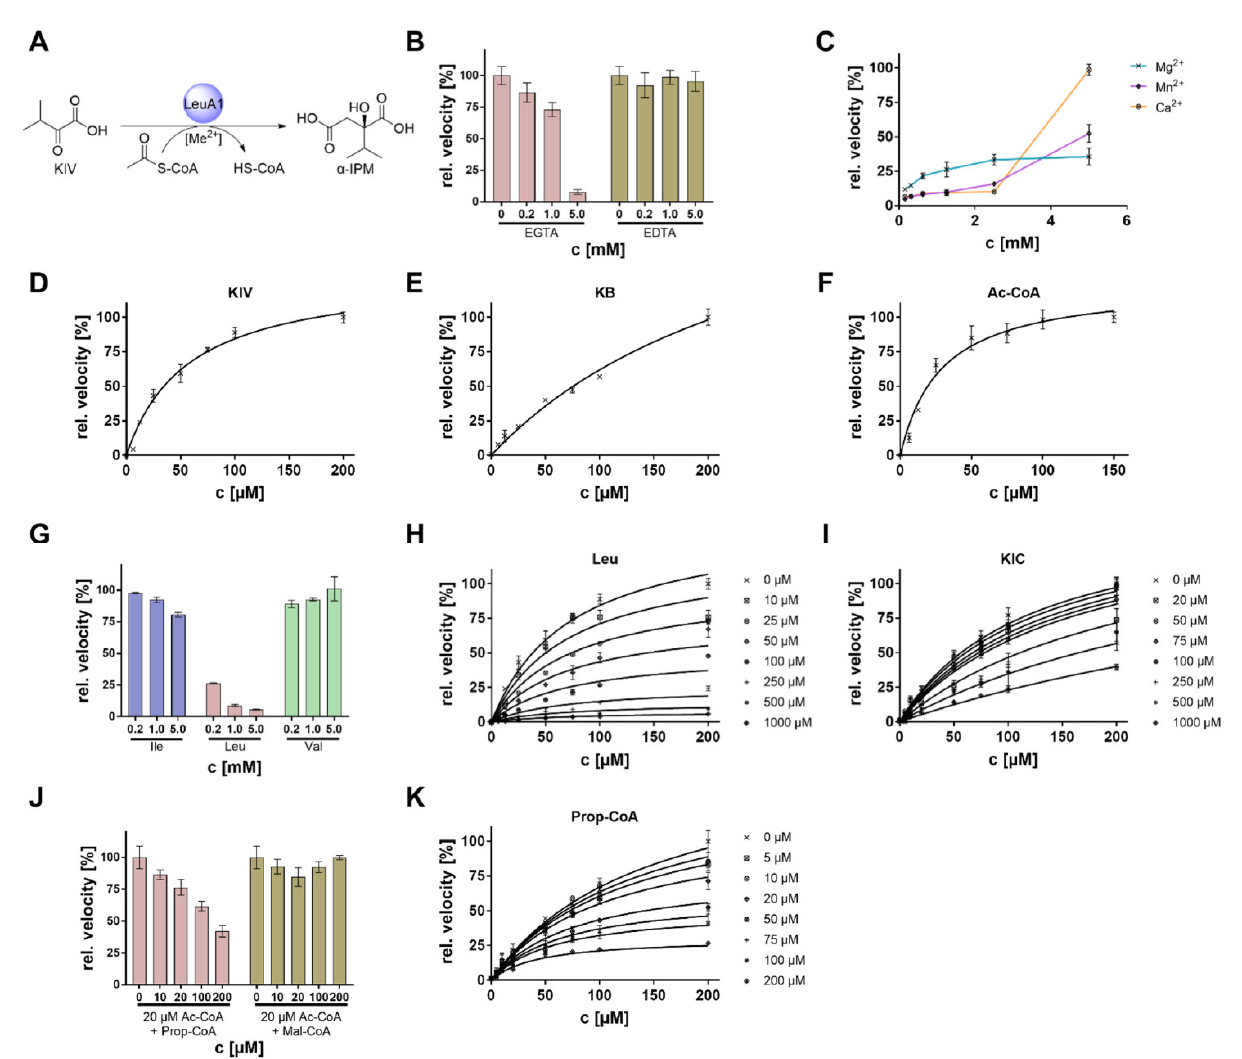
Figure 6. Metabolic regulation of the α -isopropyl malate synthase LeuA1. ( A ) Schematic representation of the LeuA1-catalyzed reaction. ( B ) Inhibition of LeuA1 by addition of chelators EGTA and EDTA. ( C ) Restoration of LeuA1 activity by additional divalent ions in the presence of 5 mM EGTA. Note that Mg 2+ restores LeuA1 at low titers, whilst Mn 2+ and Ca 2+ require higher concentrations. ( D – F ) Michaelis-Menten kinetics for the substrates KIV ( D ), KB ( E ), and acetyl-CoA ( F ). ( G ) Inhibition of LeuA1 by addition of BCAAs. Note that LeuA1 is selectively inhibited by Leu. ( H , I ) Dose-dependent inhibition of LeuA1 by addition of Leu ( H ) and its precursor KIC ( I ). ( J ) Inhibition of LeuA1 activity by addition of propionyl-CoA and malonyl-CoA. Reactions were carried out in the presence of 20 µM acetyl-CoA as co-substrate. LeuA1 is selectively inhibited by propionyl-CoA. ( K ) Dose-dependent inhibition of LeuA1 by addition of propionyl-CoA. For kinetic parameters, refer to Tables 3 and 4.